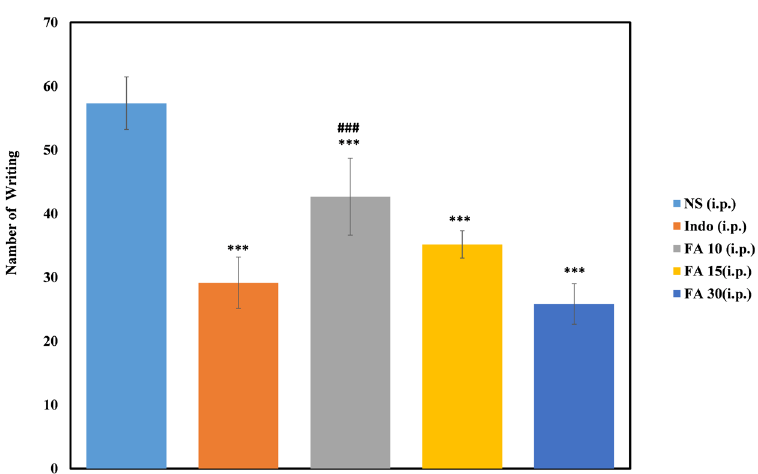
Figure 3 . Effects of i.p. injection of indomethacin (10 mg/kg) and different doses of folic acid (10, 15 and 30 mg/kg) on acid acetic-induced writhing in mice. *** P < 0.001 vs control group (NS); ### P < 0.001 vs indomethacin group (Indo). NS: normal saline; Indo: indomethacin; FA; folic acid; i.p.: